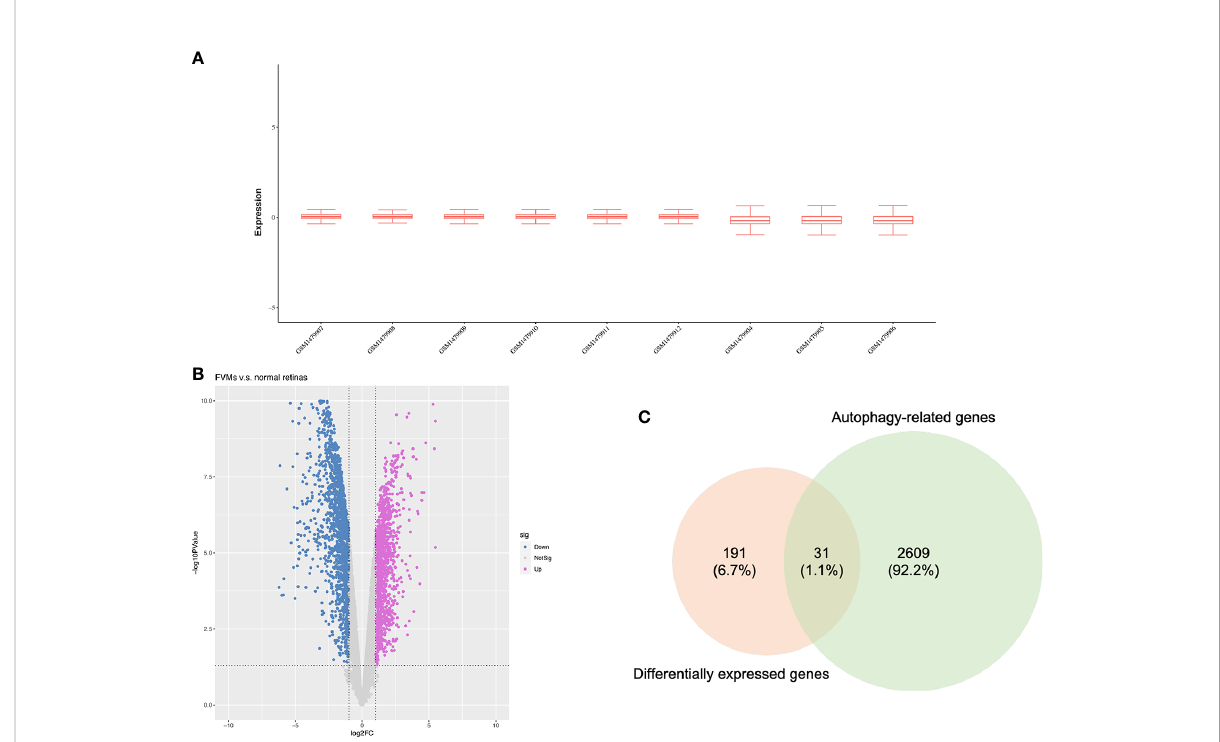
FIGURE 2 Identi fi cation of differentially expressed autophagy-related genes. (A) Box plots for the expression pro fi les after normalization. (B) Volcano plot of differentially expressed genes between the fi brovascular membranes and normal retinas. (C) Venn diagram of overlapped genes between differentially expressed genes and autophagy-related